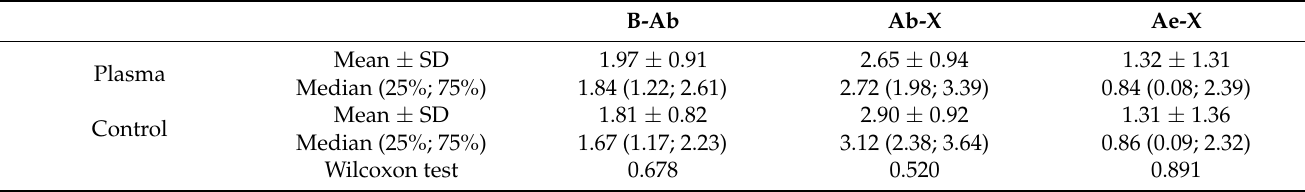
Table 1. Histometric measurements in millimeters of hard and soft tissues on the implant surface. B-Ab Ab-X Ae-X B-Ab Plasma Mean ± SD Plasma Median (25%; 75%)